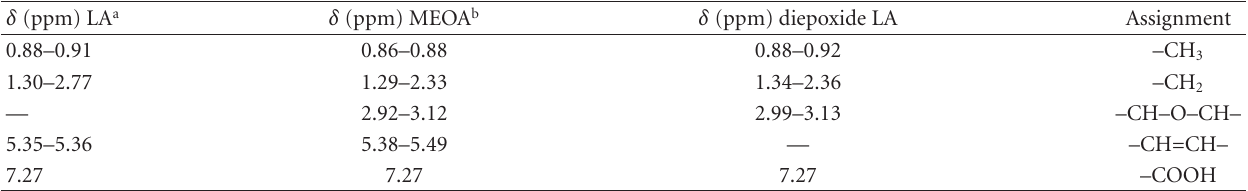
Table 9: The main signals present in 1 H NMR functional groups of LA, MEOA, and diepoxide LA.